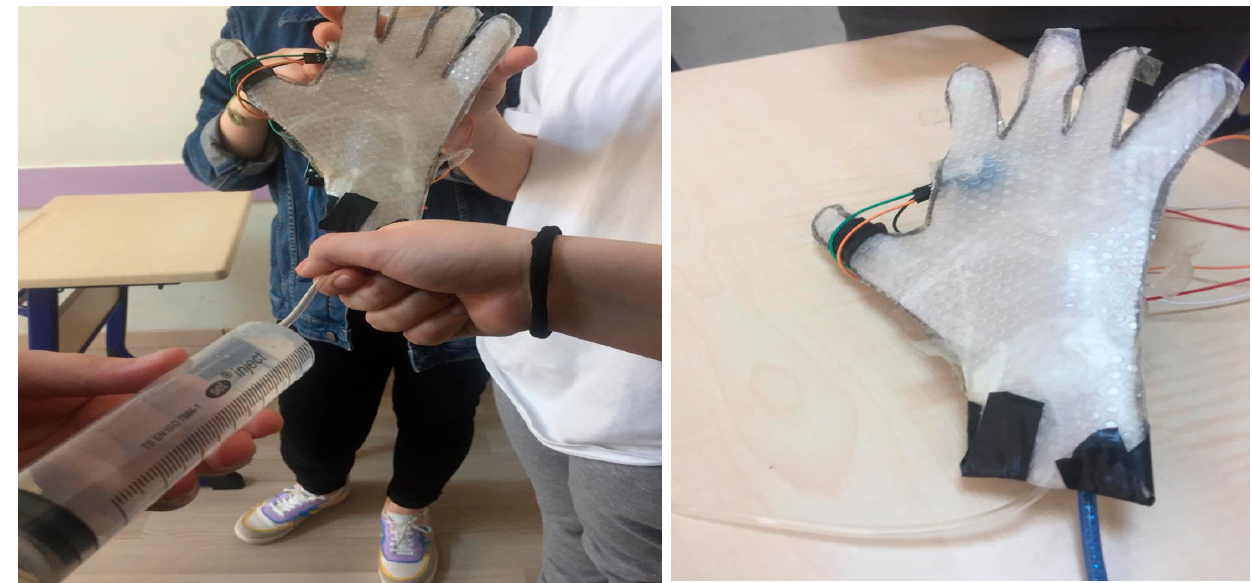
Figure 5. hand model with a moisture sensor. Figure 5. Hand model with a moisture